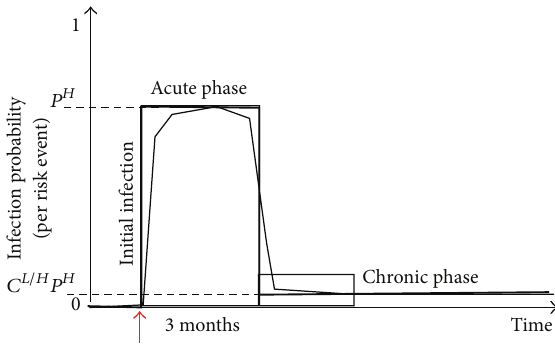
Figure 1: A two-parameter representation of HIV infectiousness as a function of infection